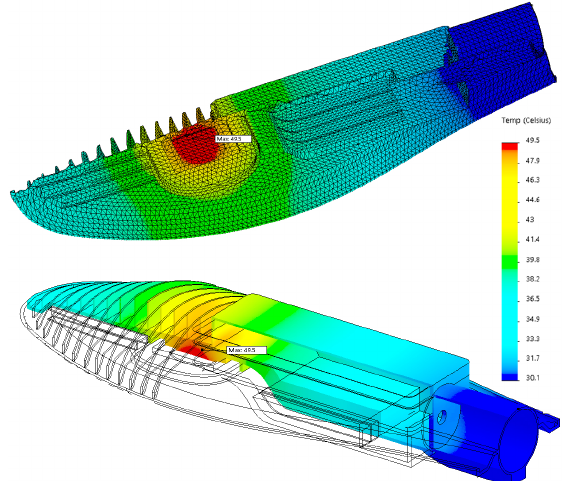
Figure 2. Geometry of the heat sink used for the numerical simulations. In the image on the top, the type of grid used for the computations is shown for one half of the heat sink. The picture below displays the full luminaire. The color scale displays the result of the numerical simulation. The LED power simulated was 50